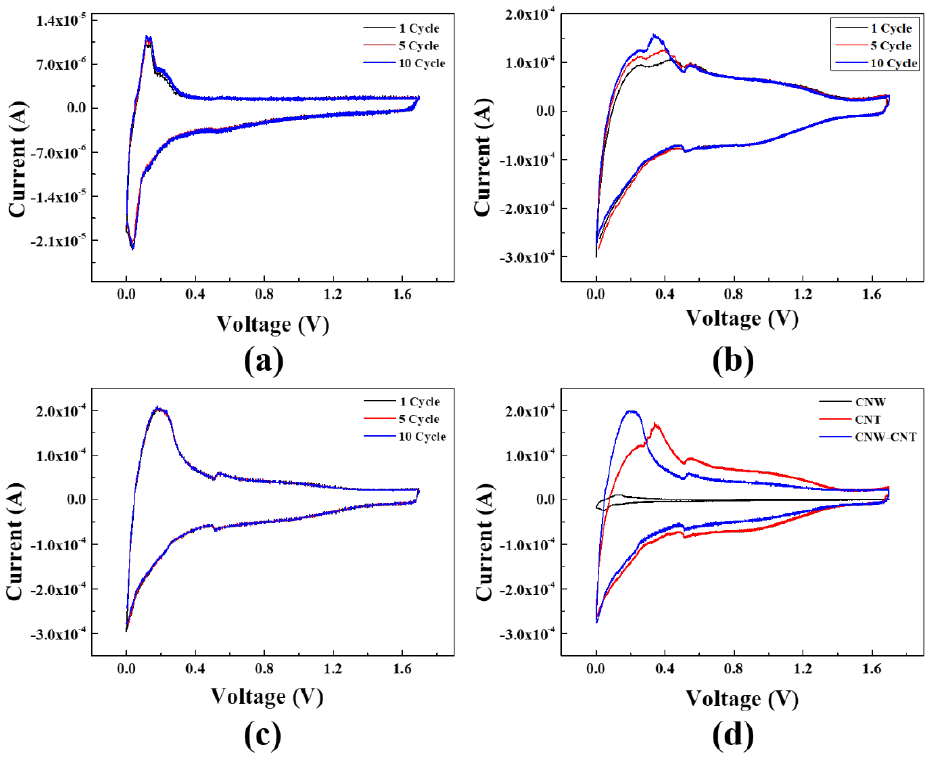
Figure 5. The CV graphs of ( a ) CNW, ( b ) CNT and ( c ) composite material for 1, 5, 10 cycle. ( d ) The CV graph of the 12th cycle for each of the samples.